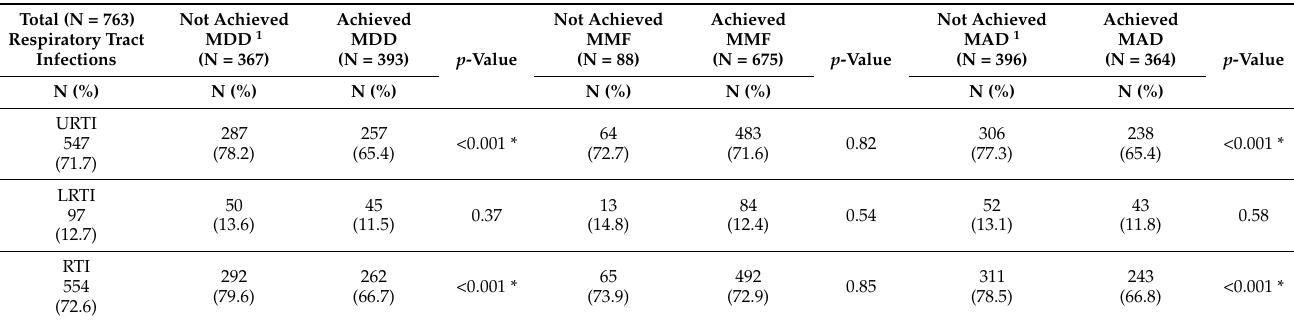
Table 1. Associations between upper and/or lower respiratory tract infections, minimum dietary diversity (MDD), minimum meal frequency (MMF), and minimum acceptable diet